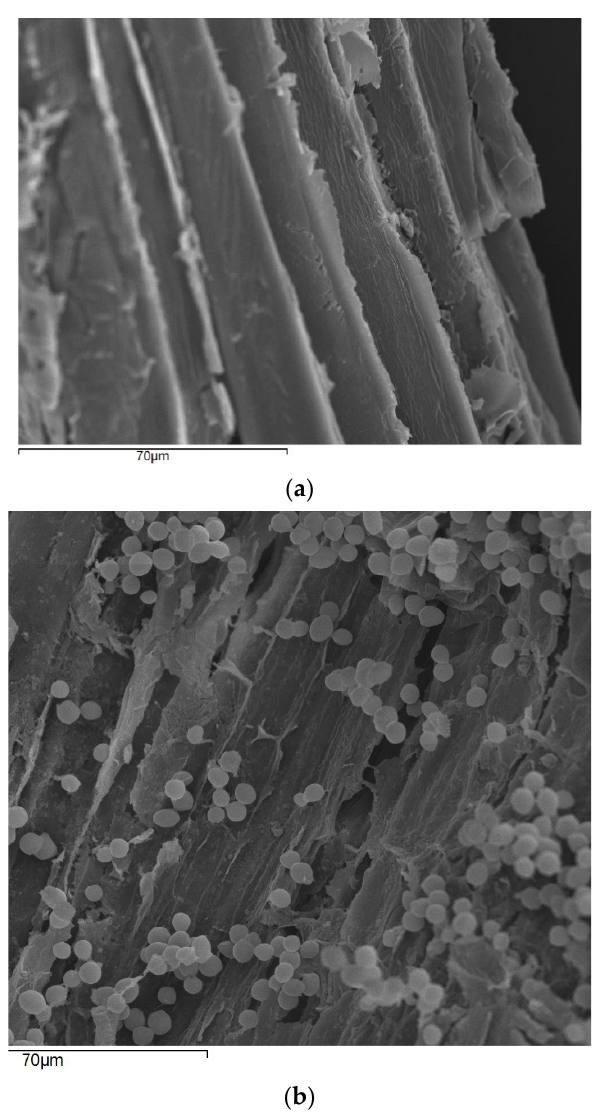
Figure 1. Scanning electron micrograph (×70 μ m) of tubular cellulose origin from delignified pine sawdust ( a ), scanning electron micrograph (×70 μ m) of delignified pine sawdust with immobilized S. cerevisiae AXAZ-1 cells ( b ).